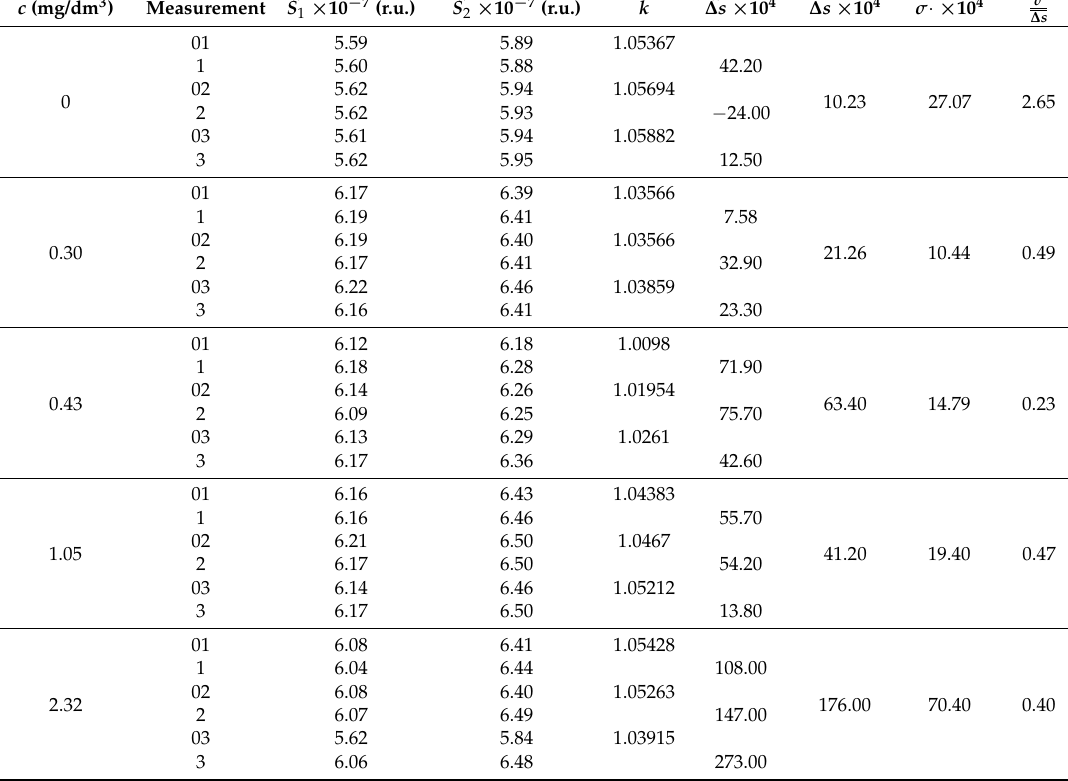
Table 2. Results of the investigation and calculation based on Equation